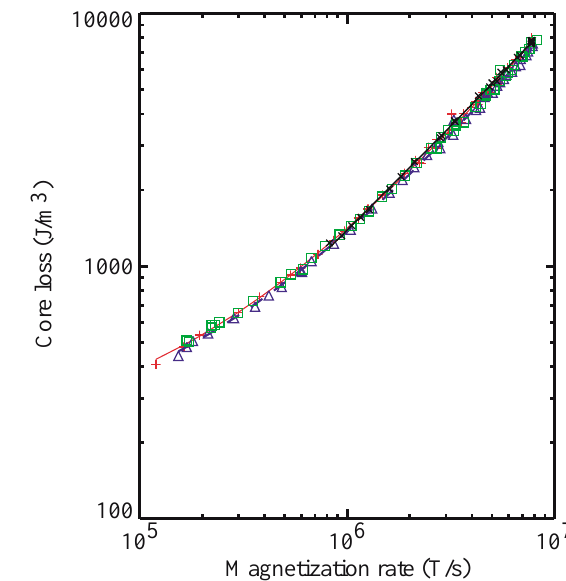
FIG. 22. (Color) Core loss versus magnetization rate for four 3% silicon steel cores, manufactured by Magnetic Metals. The data are for the listed flux swings and lamination thickness: ( (cid:1) , green) 100 m m thick at 3.20 T; ( 3 , black, solid line) selected 100 m m thick at 3.30 T; ( (cid:3) , blue, dashed line) 50 m m thick at 3.30 T; and ( 1 , red, solid line) 25 m m thick at 3.00 T.